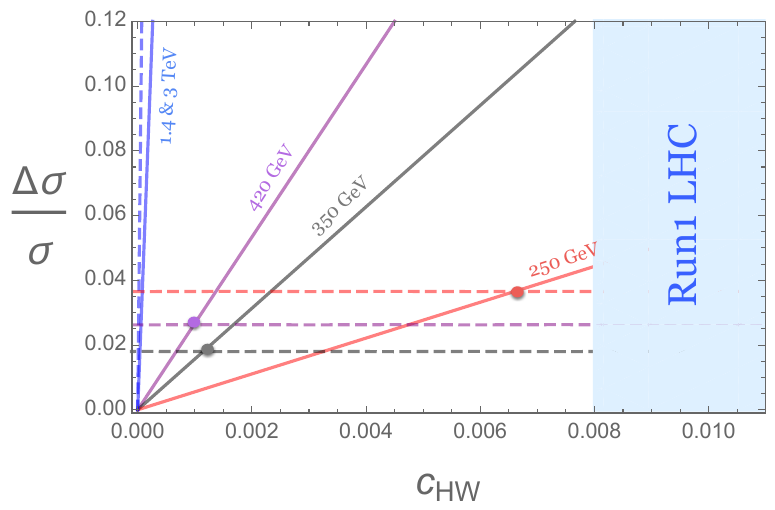
Figure 1 . Illustration of the prospective CLIC sensitivities to the dimension-6 operator coe(cid:14)- cient c HW that could be obtained from measurements of the HZ Higgsstrahlung cross-section at di(cid:11)erent centre-of-mass energies. The diagonal solid lines represent the linear dependences shown in eqs. (4.1), (4.2) and (4.3), and the horizontal dashed lines represent the measurement errors estimated in section 3. The range excluded by data from Run 1 of the LHC is shaded blue.